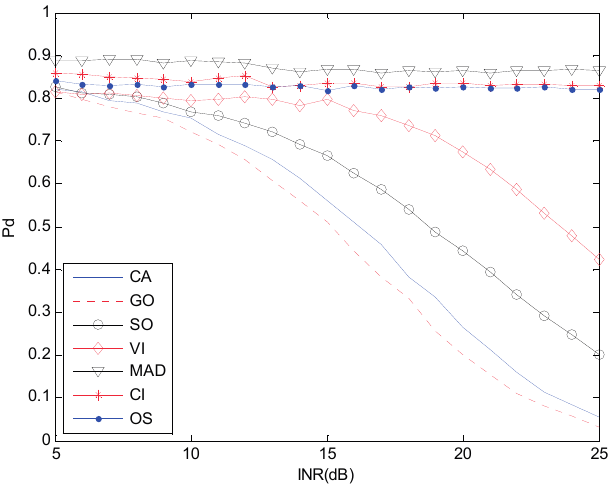
Figure 12. P vs . INR in the non-homogenous environment, r(1,1). d